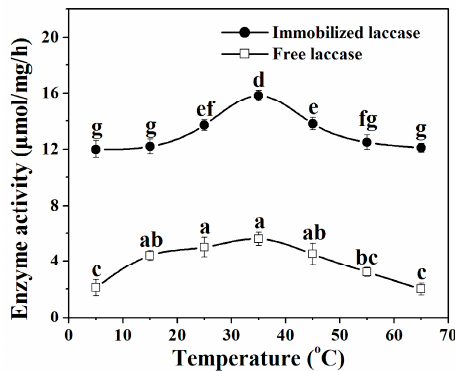
Figure 5. Effect of temperature on the activity of free laccase and laccase in the nanoflowers. Reaction conditions: trans -resveratrol 2 mmol, n -butanol (30 mL), Na 2 HPO 4 –sodium citrate buffer (15 mL) (pH